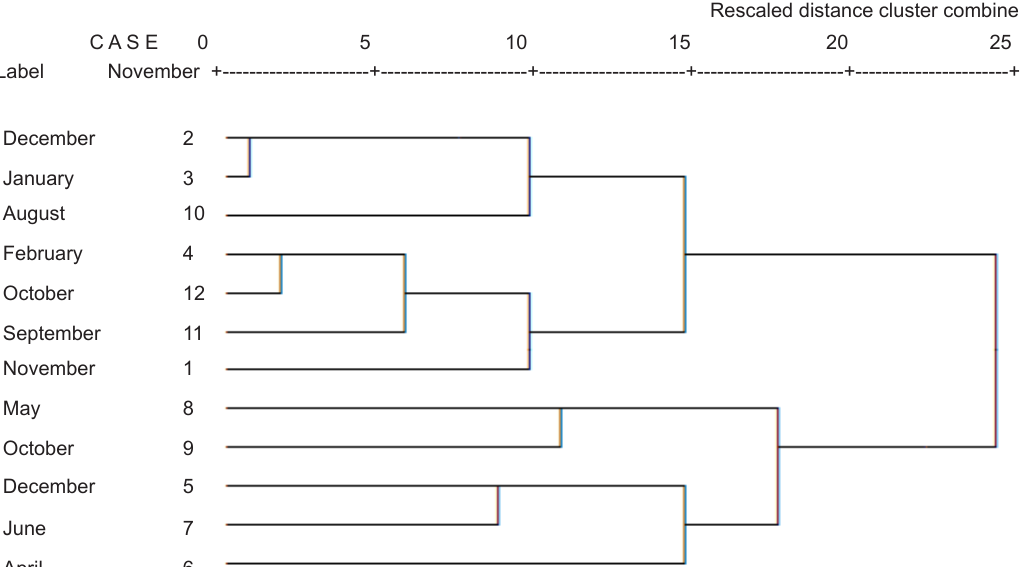
Figure 3. Hierarchical cluster analysis of Rotifera (Station